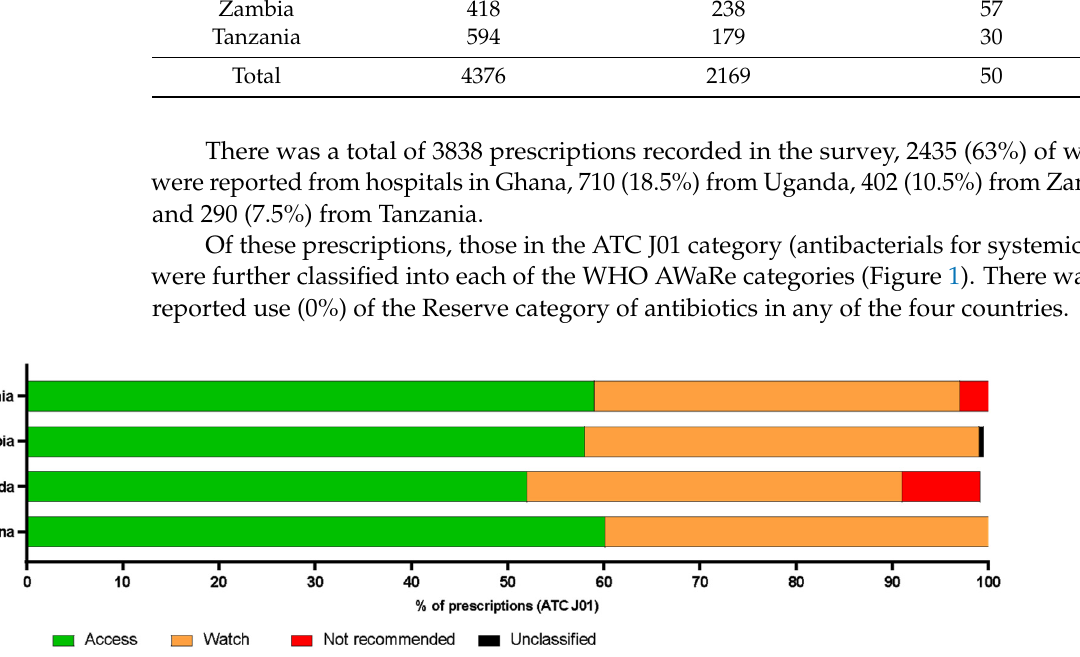
Figure 1. The proportion of antibiotics in the ACT J01 group prescribed in each of four countries. ‘Not Recommended’ antibiotic combinations were prescribed in Uganda, Tanzania, and Ghana. Ugandan hospitals had the highest prescription rate of these drugs (8%;